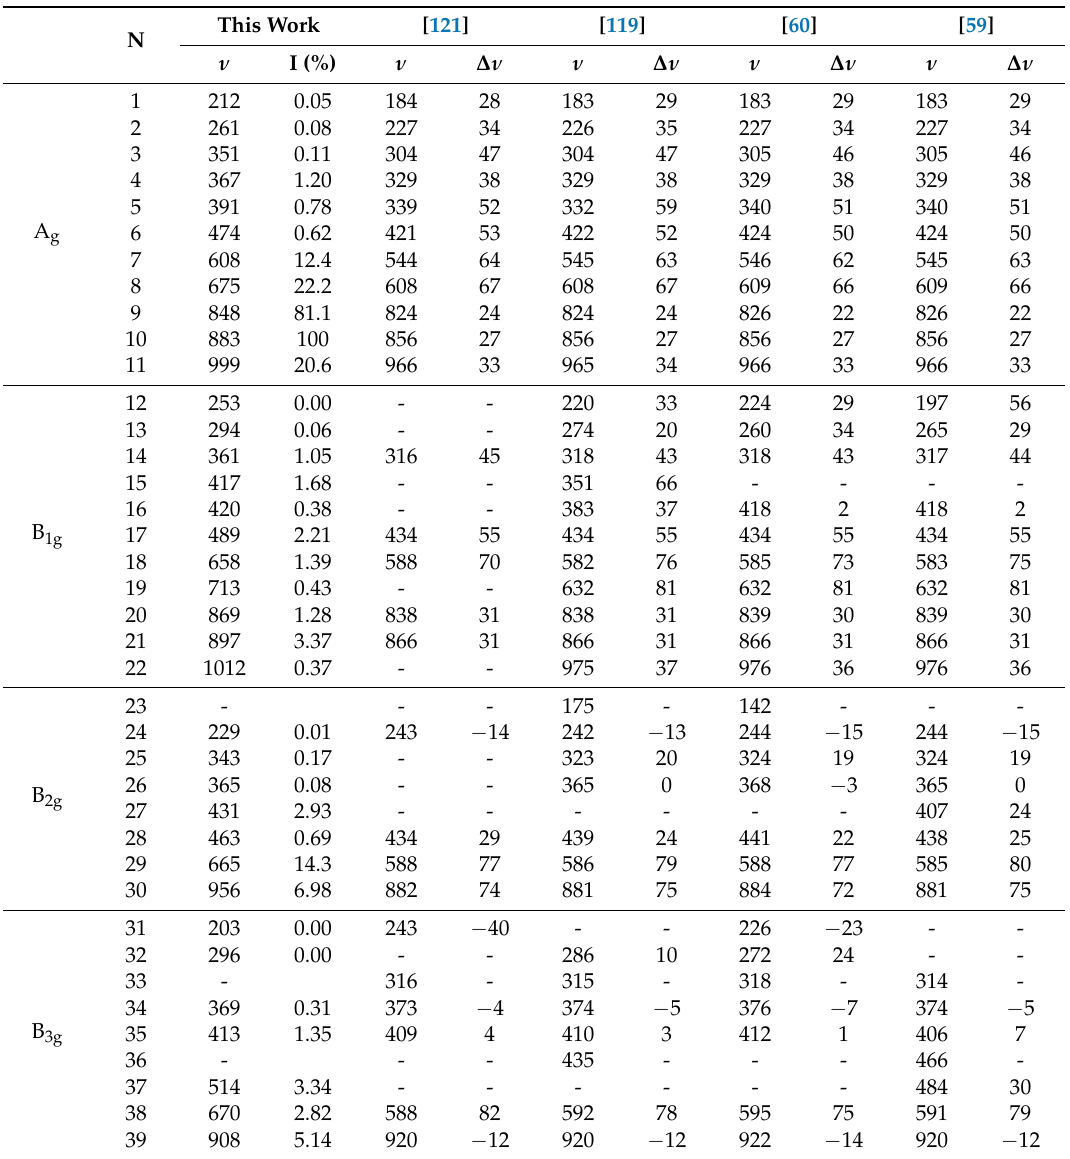
Table 5. Active Raman frequencies ( ν , in cm − 1 ) calculated in this work and their comparison with the experimental data. The shifts between the calculated and the experimental values ( ∆ ν ) are also